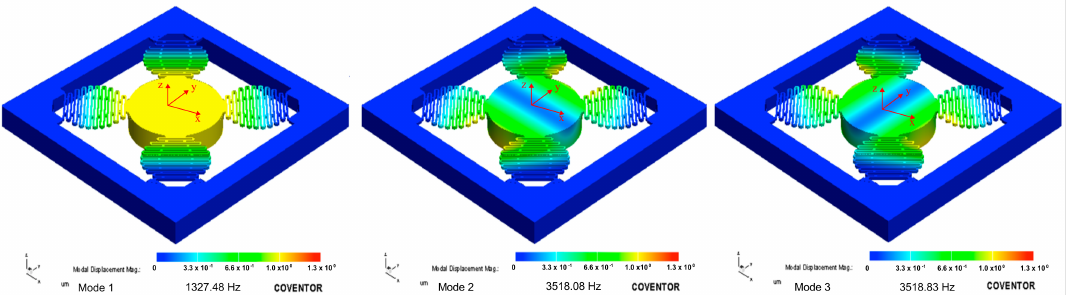
Figure 9. Resulting modes of vibration of the system with the coubset on the springs (shown with an exaggeration factor of